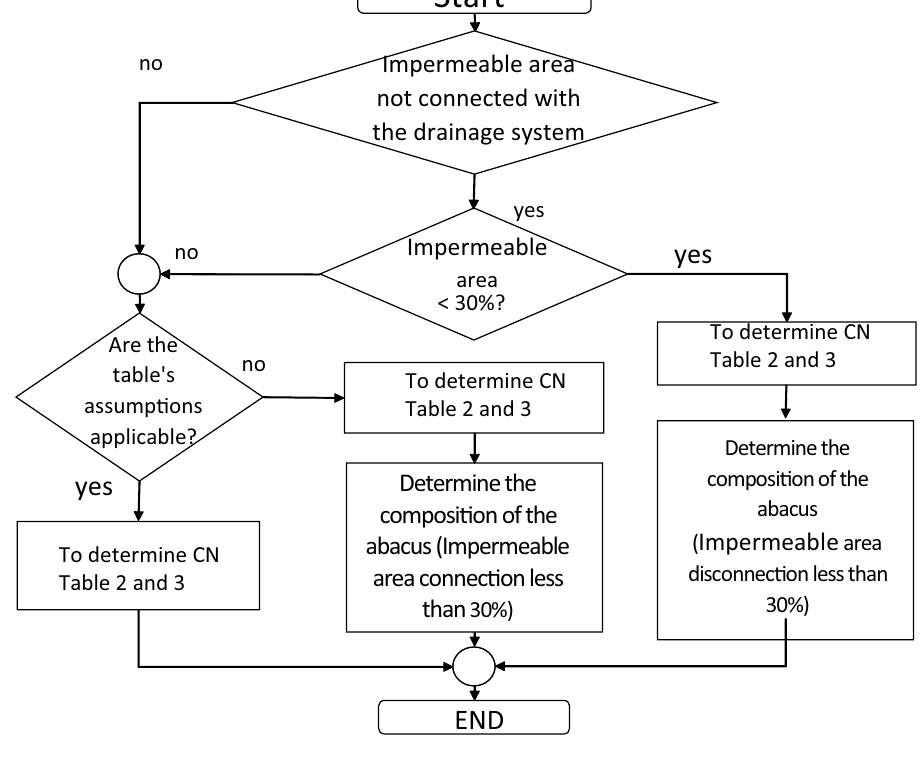
( tc ) according to different